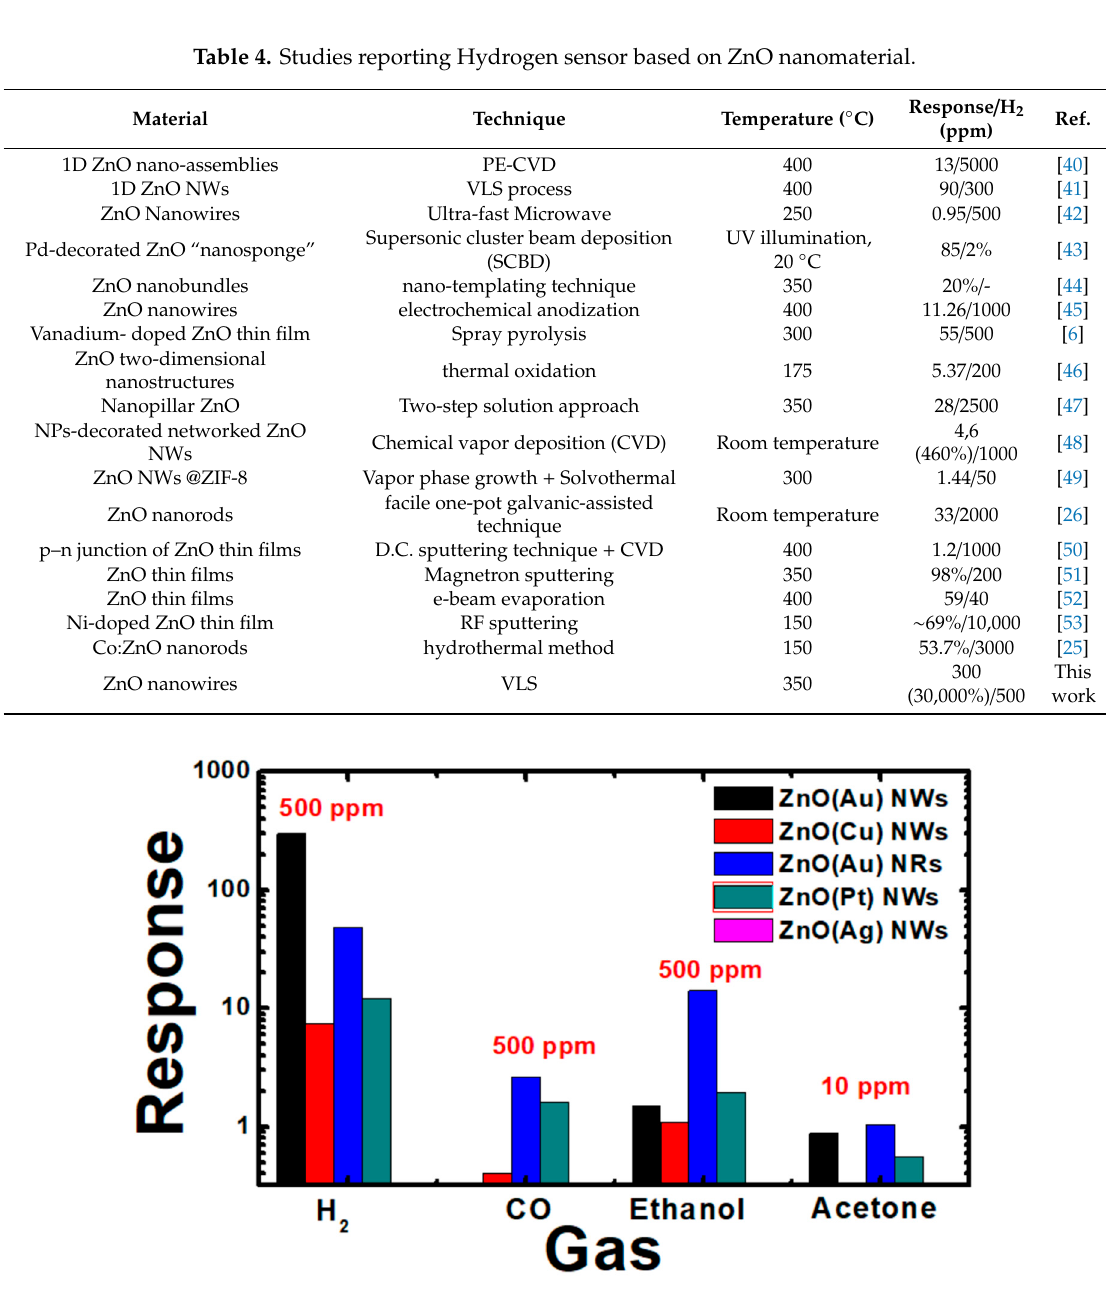
Figure 10. Selectivity histogram of 1D ZnO nanostructures using different catalysts.